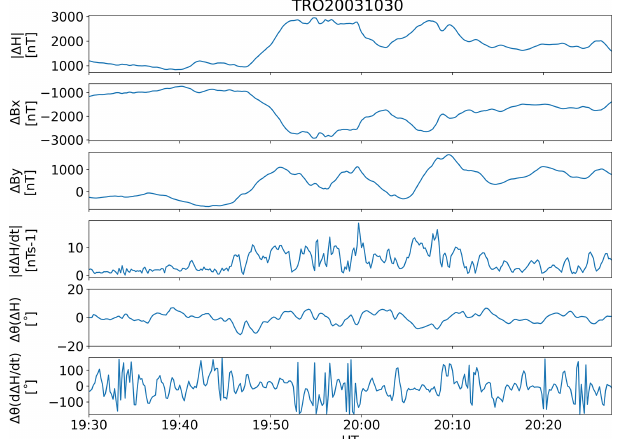
Figure 3. Different quantities related to the horizontal magnetic field at Tromsø station during 1h of the Halloween event on 30 Oc- tober 2003. Panels from the top are (1) magnitude of the horizontal magnetic field, (cid:49) H , (2) (cid:49) B x component, (3) (cid:49) B y component, (4) amplitude of the time derivative, d (cid:49) H / d t , (5) change in direc- tion, (cid:49)θ ( T =1min) of H and (6) (cid:49)θ ( T =1min) of d (cid:49) H / d t .